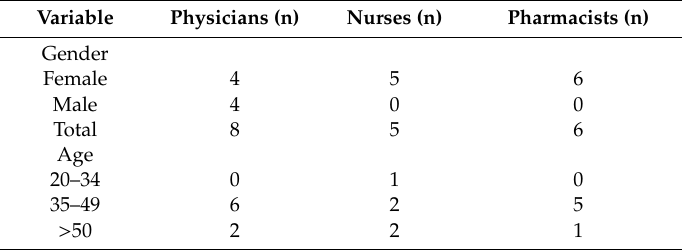
Figure 1. Themes arising from the interviews of healthcare professionals on oral drug administration practices in a children’s hospital grouped into categories and subcategories. Table 2. Characteristics of the interviewed healthcare professionals in the focus